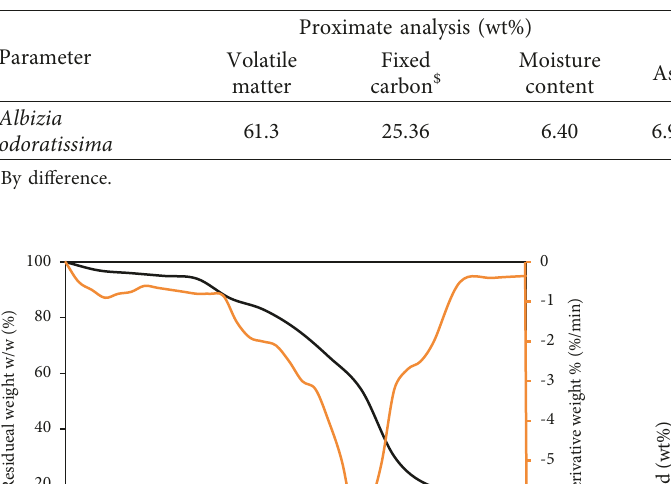
Table 1: Characterization of biomass.